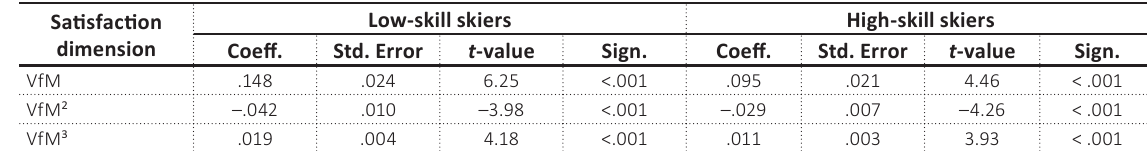
Figure 10. Value-for-Money in two loyalty groups Table 3. Value-for-Money structural coefficients for low- and high-skill